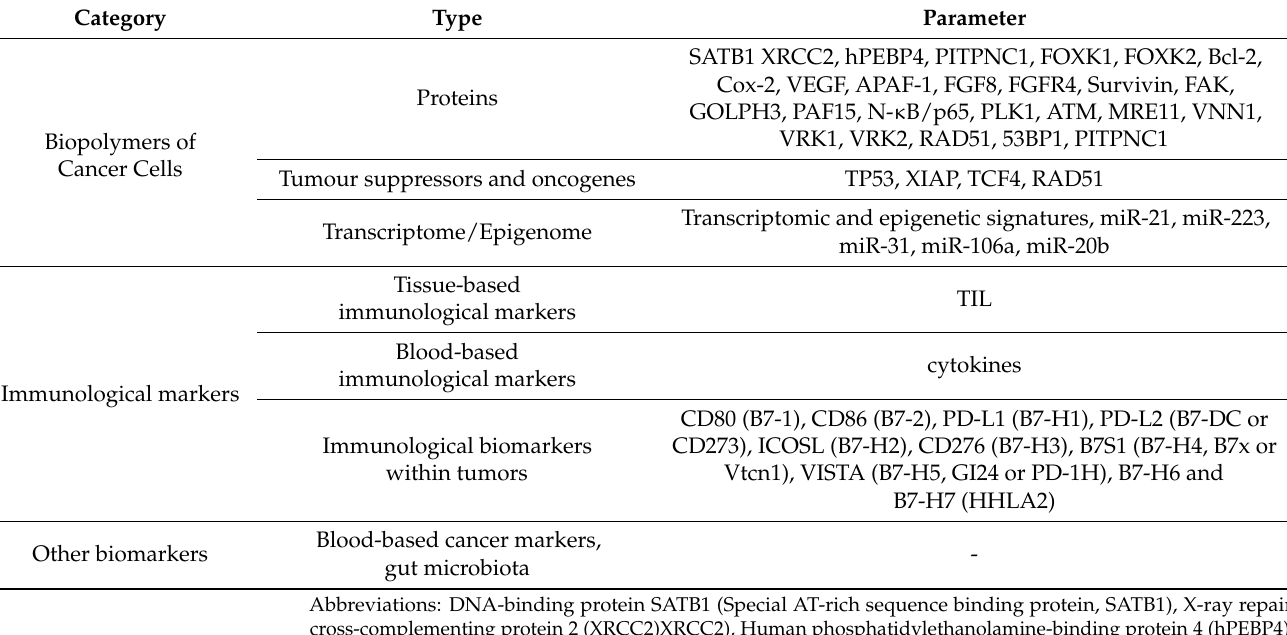
Table 1. Biomarkers suggested predicting neoadjuvant treatment response in rectal